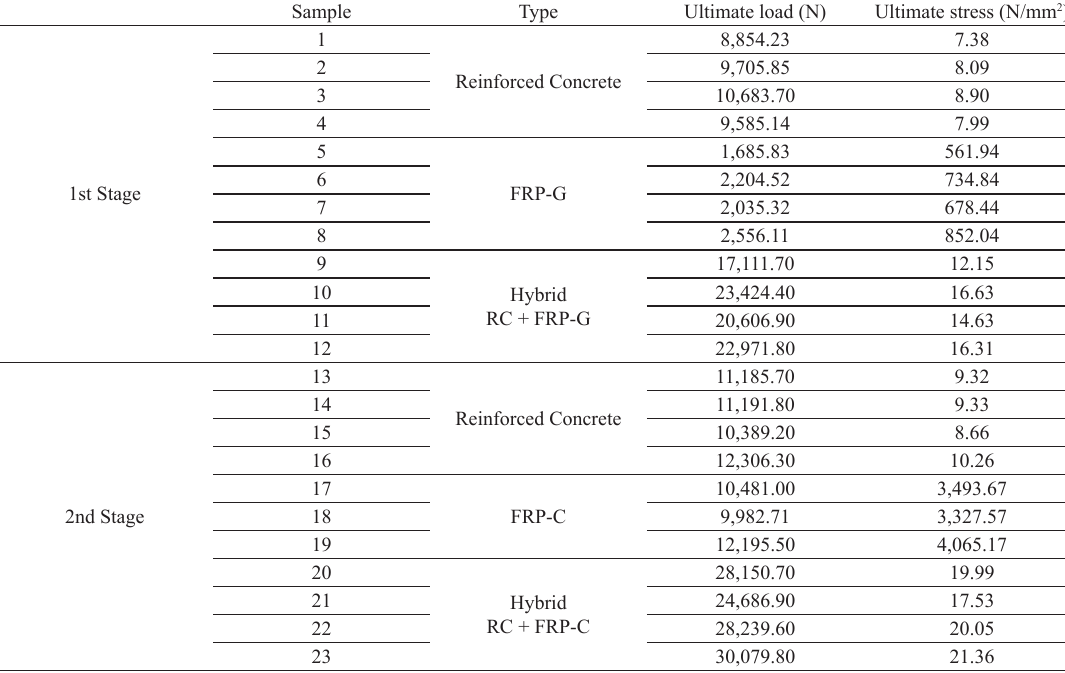
Table 2. Bending tests results.